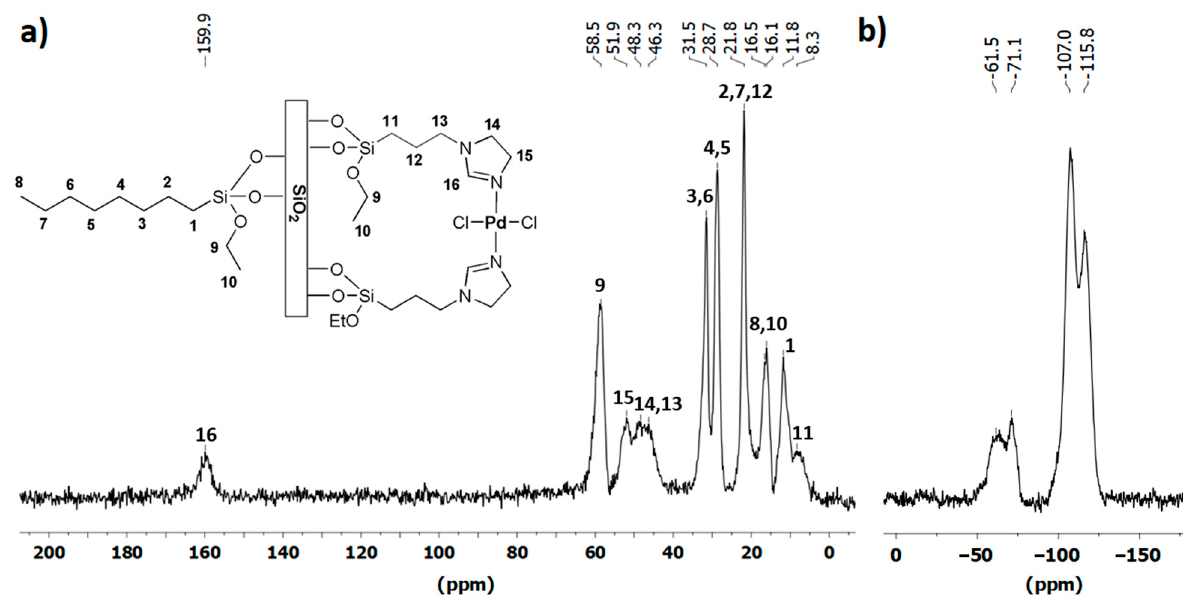
Figure 4. ( a ) Solid-state 13 C and ( b ) 29 Si CP-MAS NMR spectra of catalyst 2